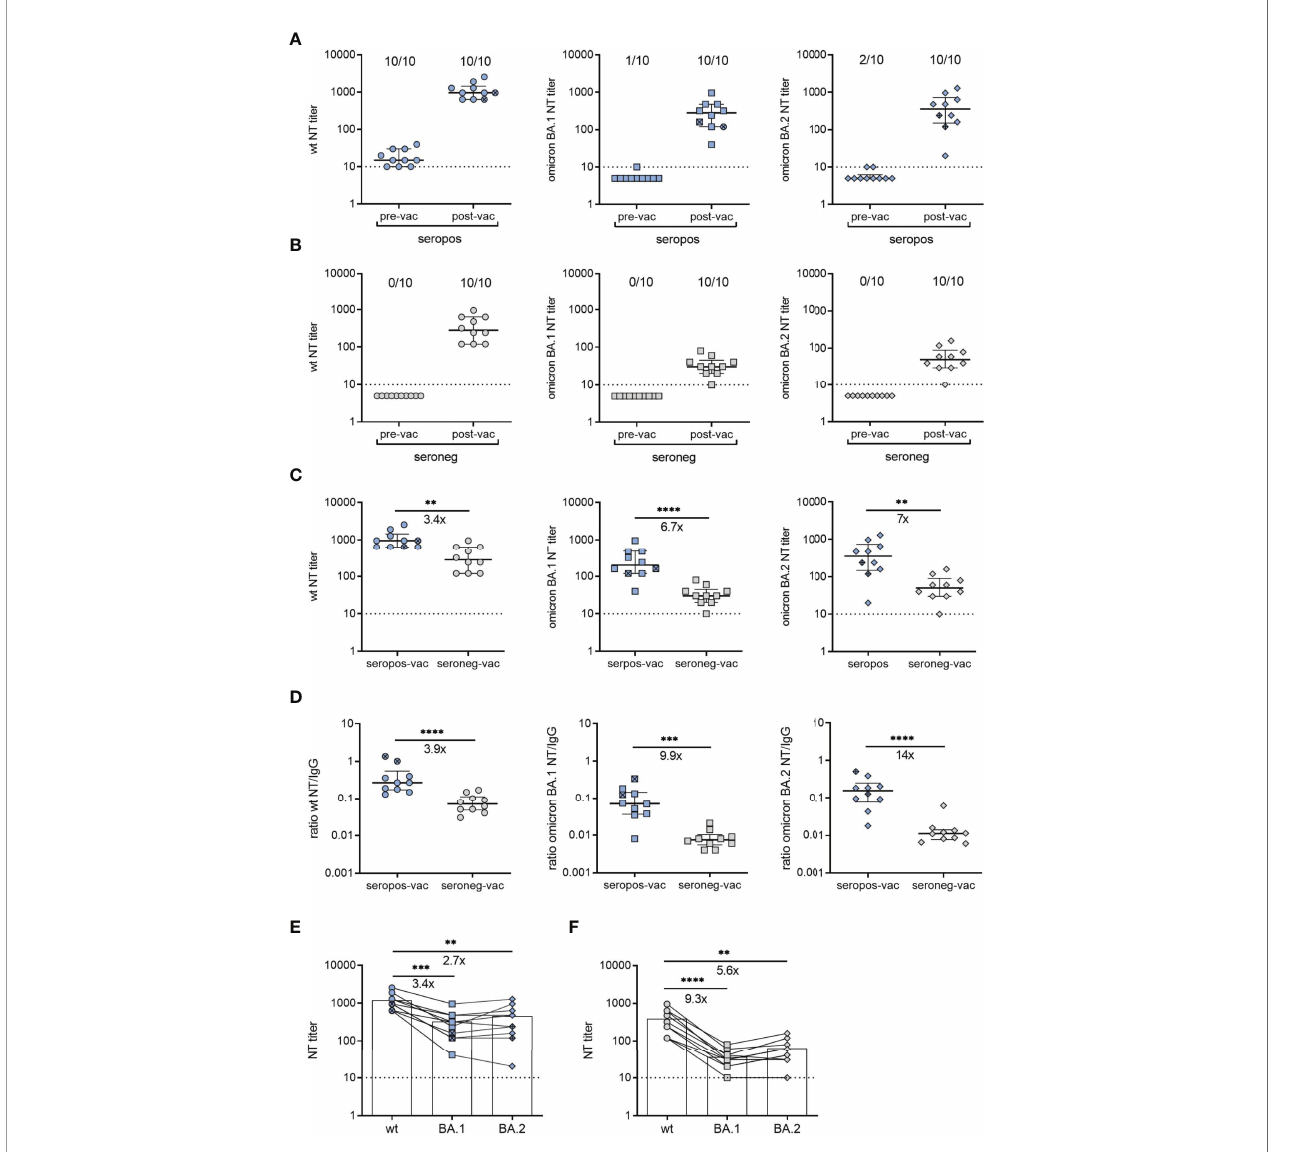
FIGURE 3 | Neutralizing antibodies after vaccination of SARS-CoV-2-recovered and seronegative children. (A) Neutralizing antibody titers against an early pandemic virus strain (wildtype, wt), omicron BA.1 or BA.2 variants before and 1.1 [IQR 0.9] months after vaccination (n = 8, BNT162b2; n = 2, Ad26.COV2-S) of children with a con fi rmed SARS-CoV-2 infection. (B) Neutralizing antibody titers against wt strain, omicron BA.1 or BA.2 variants before and 1.3 [IQR 0.6] months after vaccination of seronegative children (n = 10) BNT162b2. (C) Post-vaccination neutralizing antibody titers of the two groups against wt strain, or omicron BA.1 or BA.2 variants. (D) Ratios of neutralizing antibody titers and RBD-speci fi c IgG values against wt, omicron BA.1 or BA.2 variants (E) Postvaccination neutralizing antibody titers against wt, omicron BA.1 or BA.2 from seropositive children (n = 10) and (F) seronegative children (n = 10). Samples from the same person are connected by lines. Pre-vac, pre-vaccination; post-vac, post-vaccination; seropos, seropositive; seroneg, seronegative. In panels A and B, the numbers above the plots indicate the proportion of samples that were positive for neutralizing antibodies against the respective variant. Bars represent median ± IQR. Ad26.COV2-S indicated by cross symbol. The dashed line indicates the cut-off of the assays. Groups were compared with the Mann-Whitney U test (panels C , D ) and Dunn´s multiple comparison test (panels E , F ) (**P < 0.01; ***P < 0.001; ****P < 0.0001). Fold-differences in panels (C – F) are